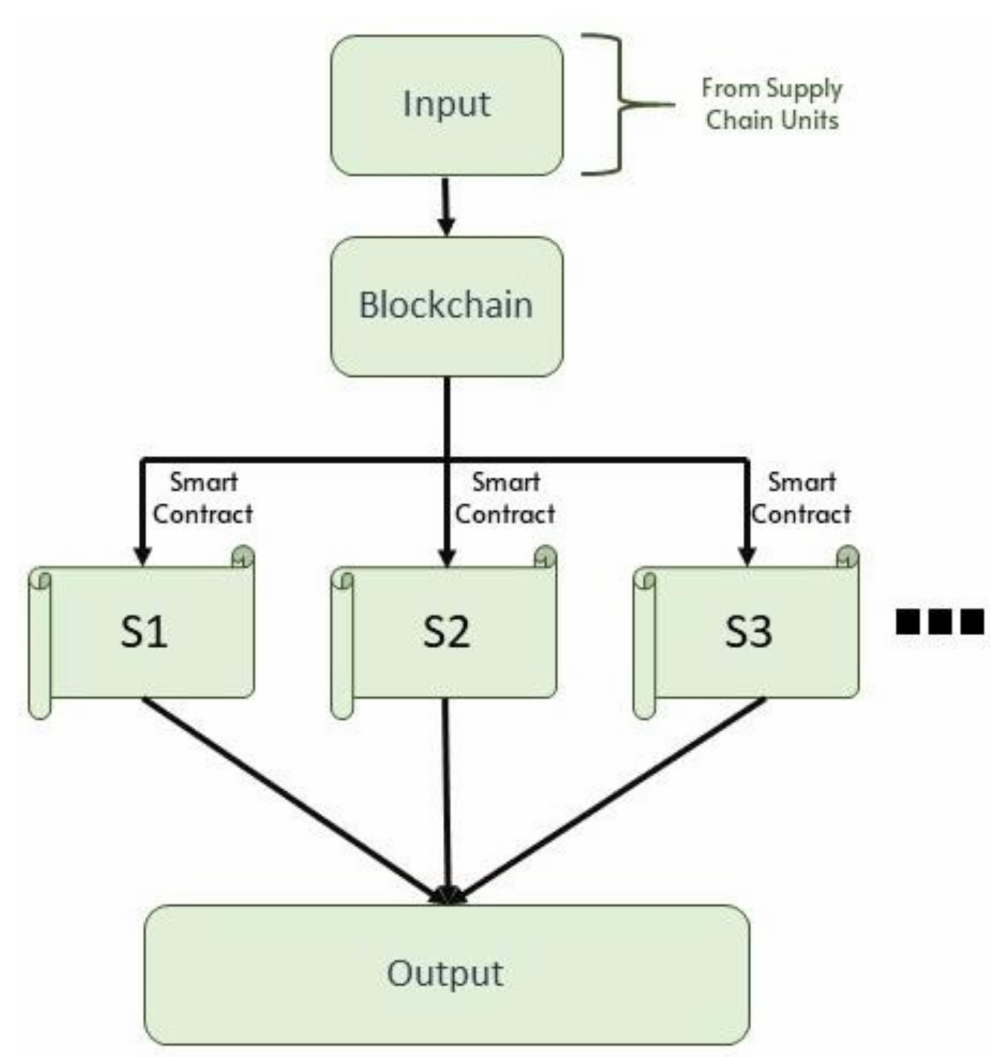
Figure 7. Proposed blockchain layer